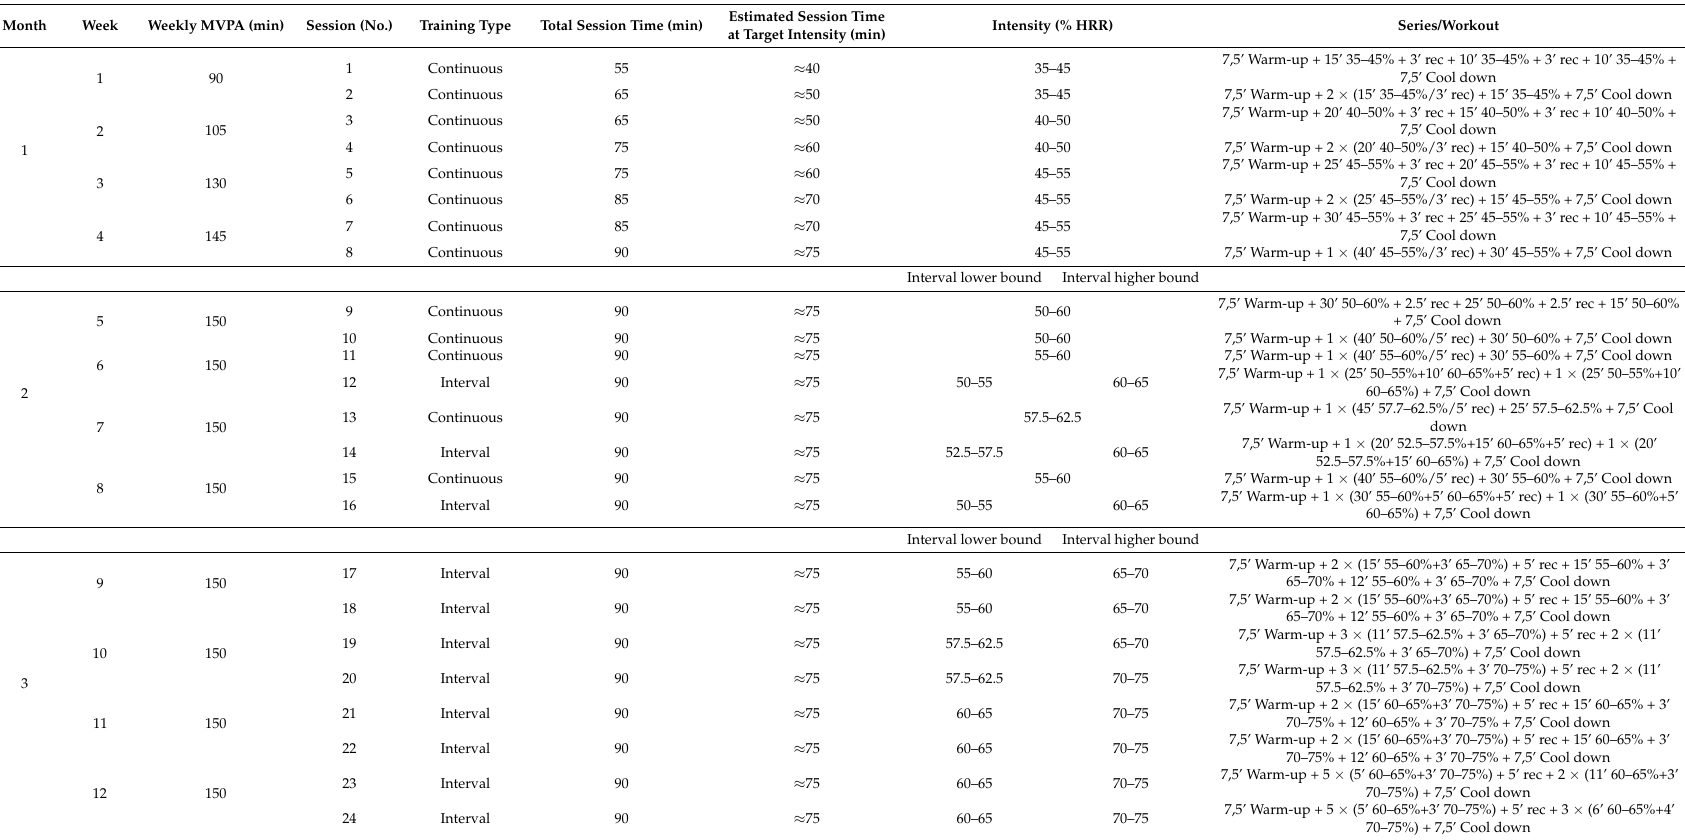
Table 1. Summary of the prescribed training